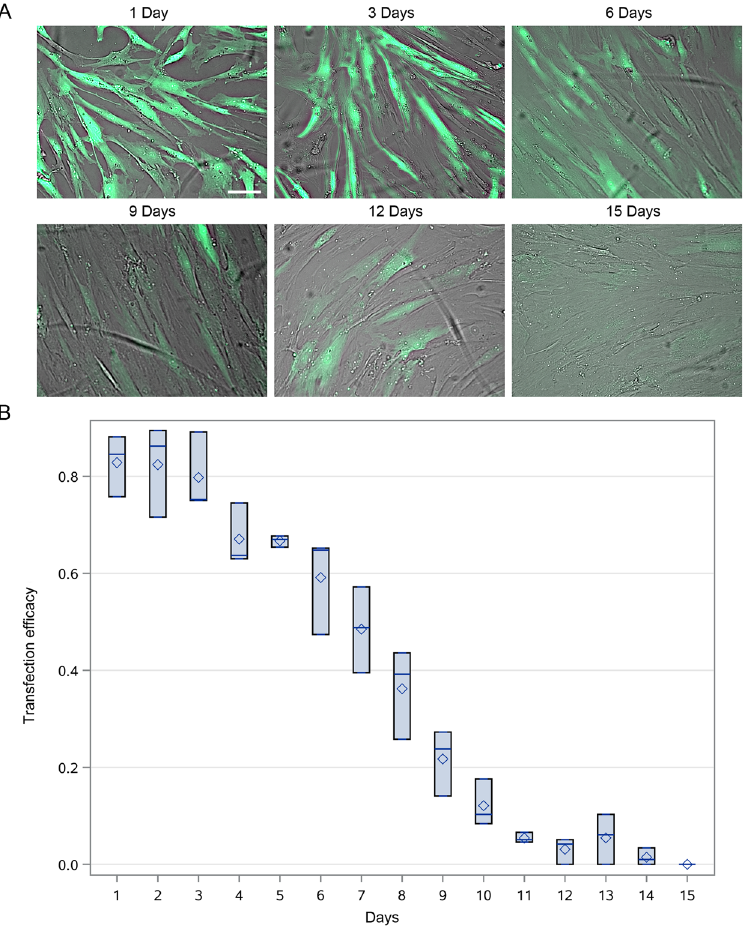
Figure 3. Time-course eGFP protein synthesis after mRNA transfection in MSCs. Time-course of eGFP protein presence in MSCs after eGFP-mRNA transfection on intravital fluorescent images ( A ) with subsequent quantification ( B ). Green – eGFP protein. Error bars are box-and-whiskers plots containing the mean, quartiles (box) and minimum and maximum observations (whiskers). Transfection efficiencies have been calculated from three independent experiments. Scale bar located in the top left image: 20 µ